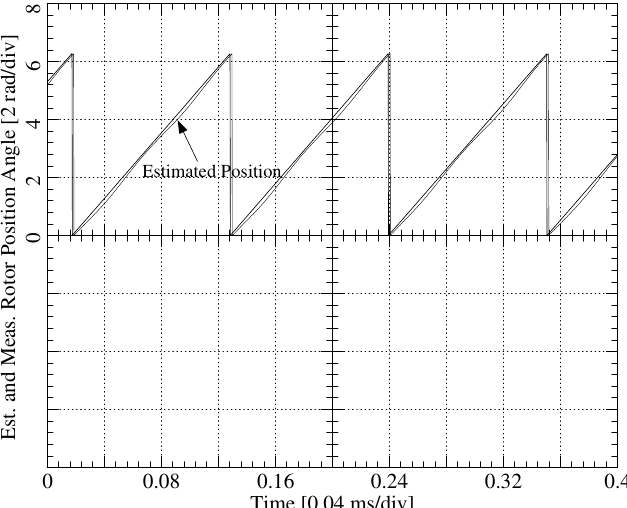
Figure 17. Experimental steady-state (90 r/min) measured and estimated rotor position waveforms under full load (2 N·m) with K = 5 (high) while R s is increased by 82.35% and λ f is decreased by 40% of its original